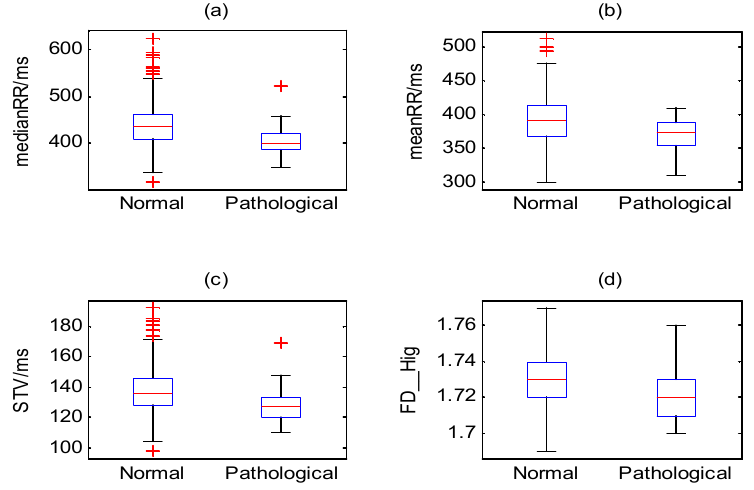
Figure 6. The distribution of normal and pathological classes for the four most highly ranked features (medianRR, meanRR, STV, and FD_Hig) using box plots.